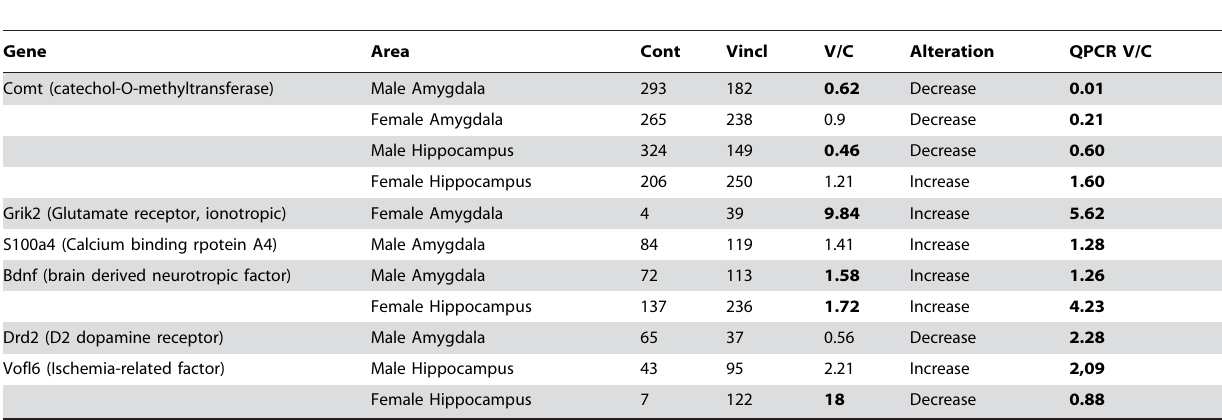
Table 2. Genes related to mental health disorders that show a significant (in bold) alteration in expression in Vinclozolin-lineage